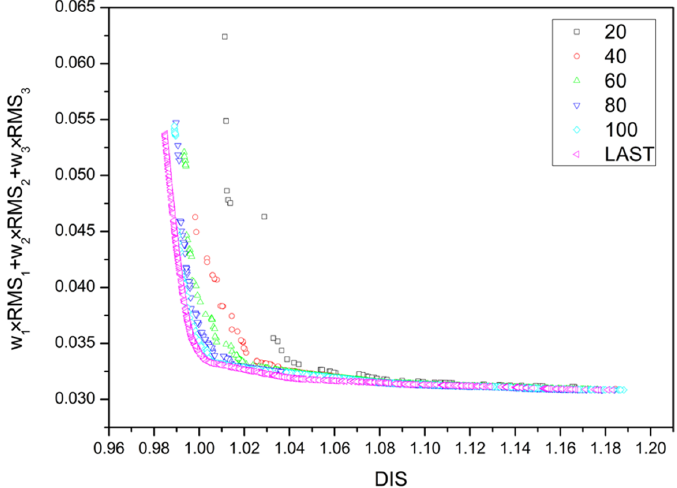
Figure 6. Pareto frontier evolution process.